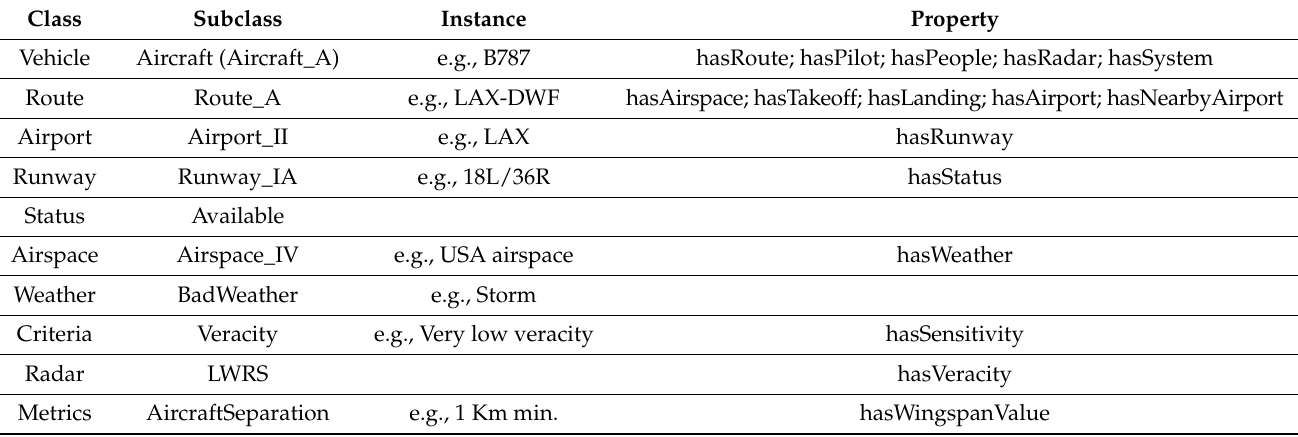
Table 5. AAO Components.